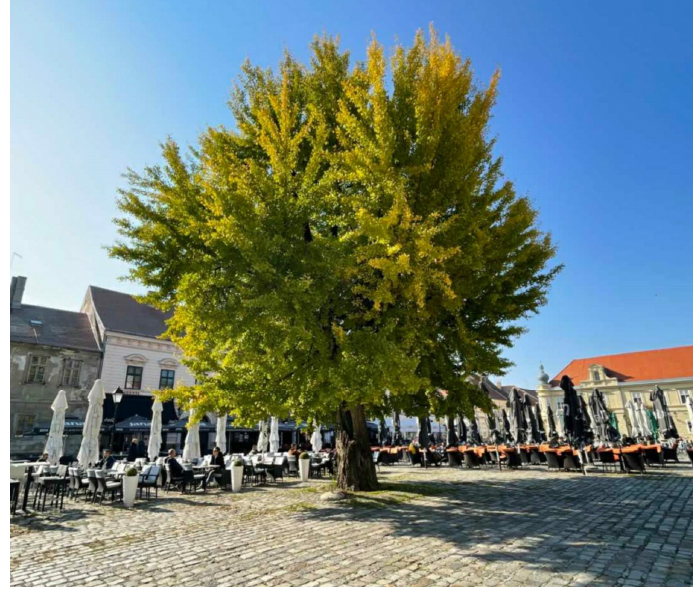
Figure 1. Approximately 200-year-old ginkgo tree in the old part of the city of Osijek, Croatia (photo taken in October 2021).